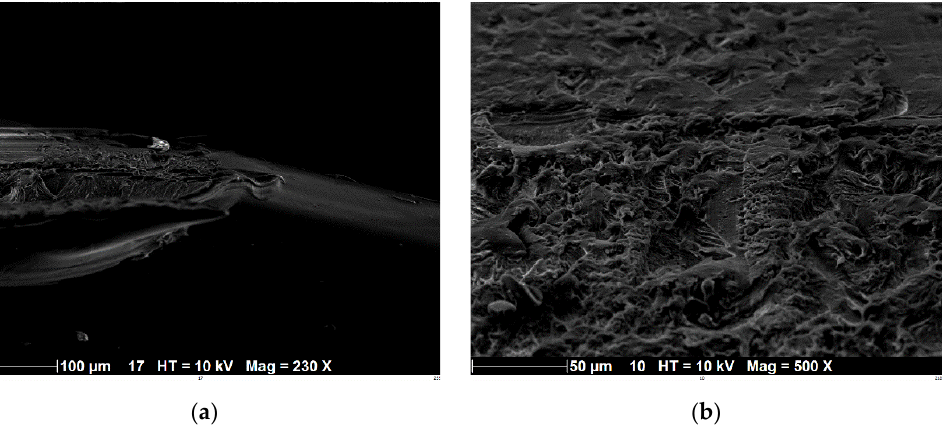
Figure 4. SEM imaging of PLC filament: ( a ) view along the filament length; and ( b ) close-up view of a filament cross-section.